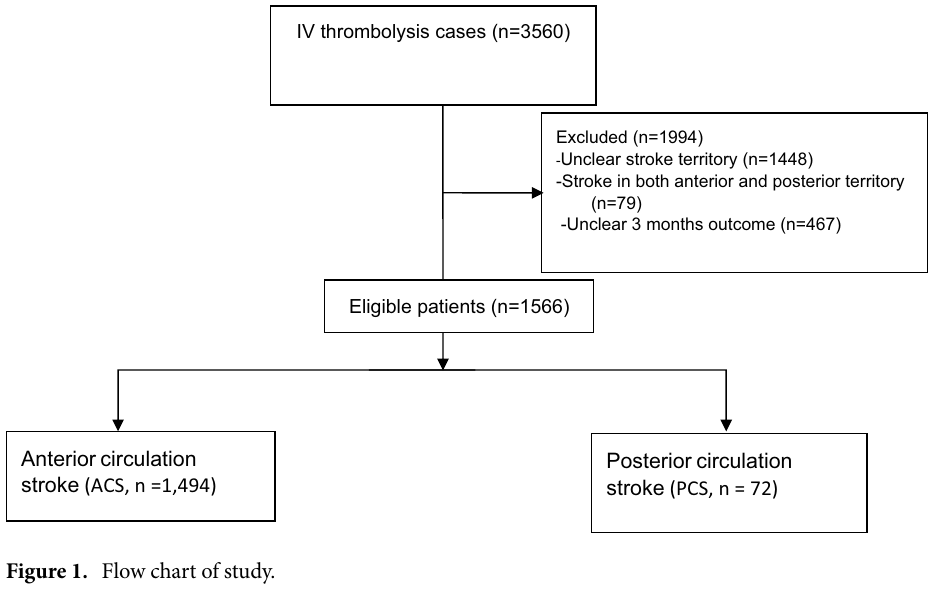
Figure 1. Flow chart of